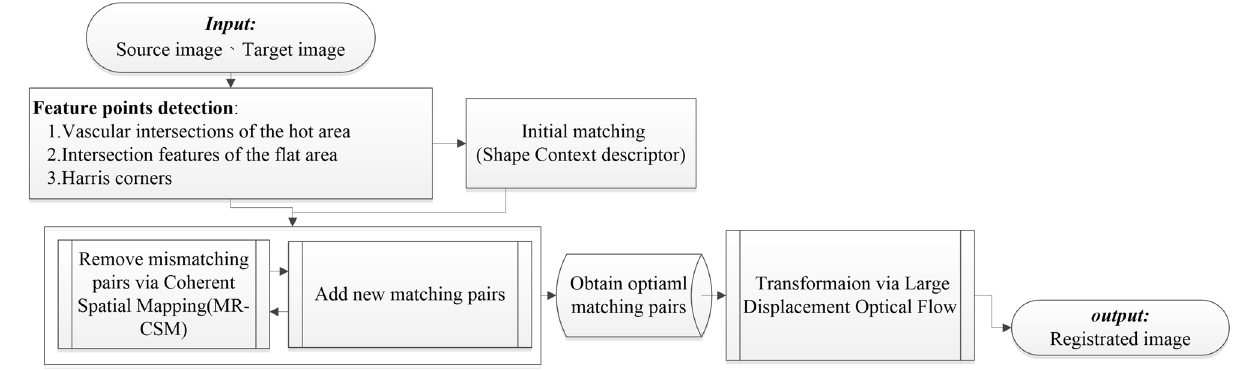
Figure 13. Flowchart of the proposed registration algorithm.